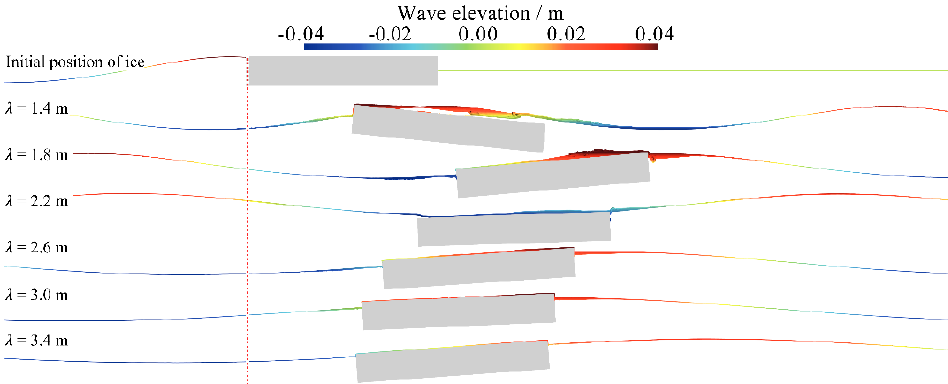
Figure 14. Distribution of fluid velocity around ice floes. ( a ) Triangle ice floe; ( b ) Square ice floe; ( c ) Circle ice floe.